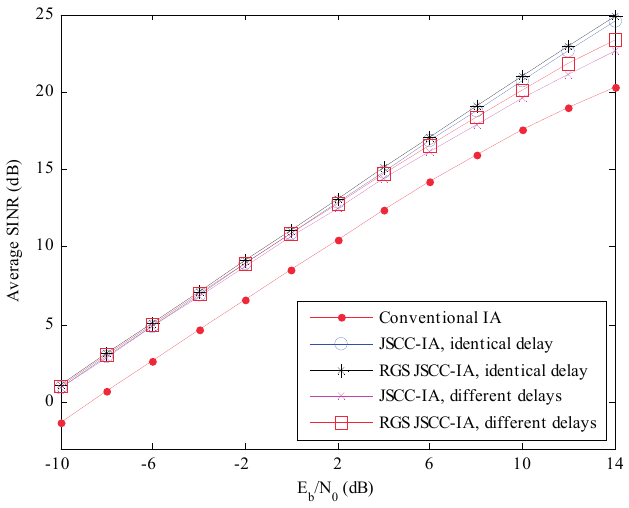
Figure 15. The average received SINR of the conventional IA scheme, the JSCC-IA schemes with identical/different propagation delays and the RGS JSCC-IA schemes with identical/different propagation delays in the (4 × 4, 1) 20 asymmetric